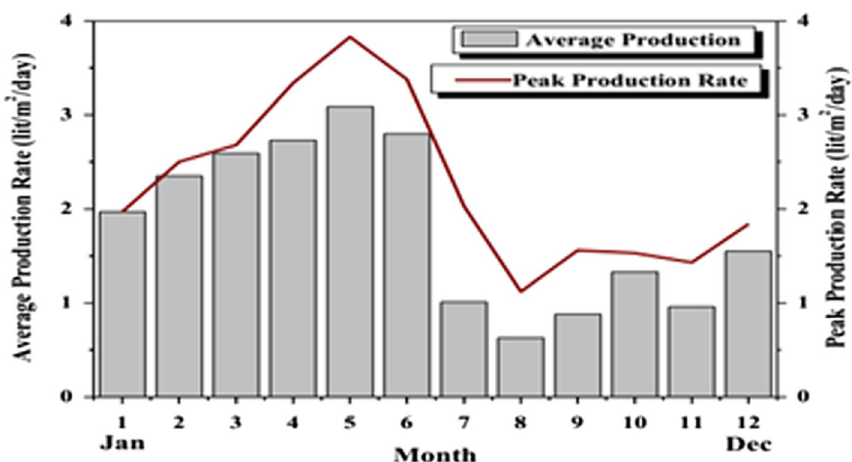
Fig. 5 Comparison between average and peak production rate for the TSS for different months